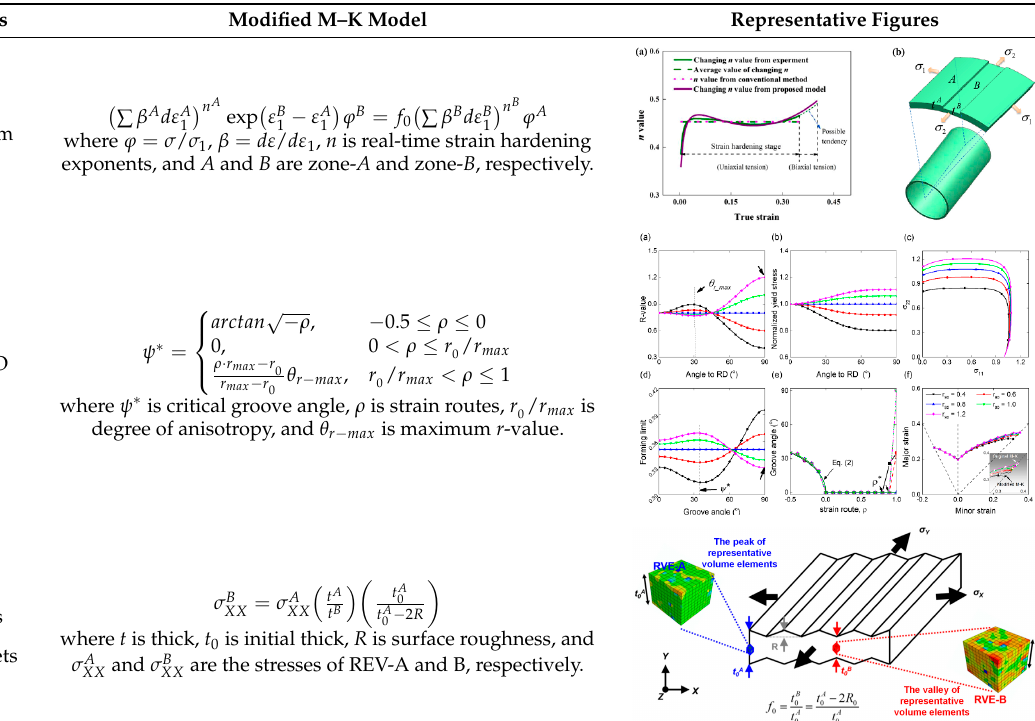
Table 1. Summary of research results on modified M–K model in recent years.